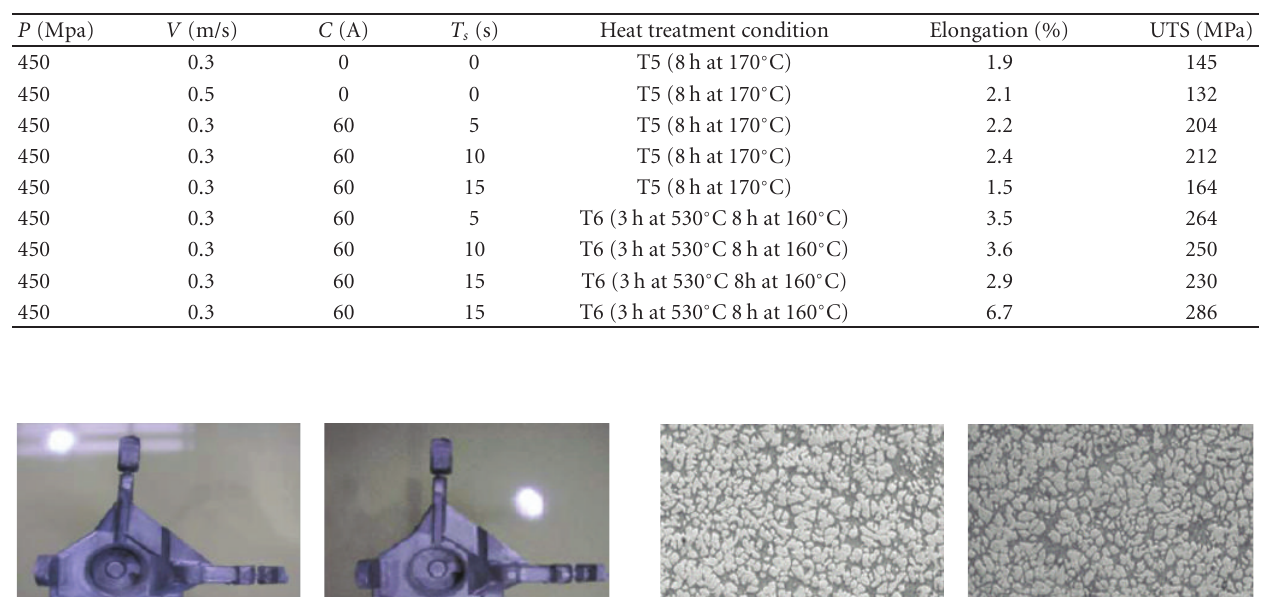
Table 2: The mechanical properties of knuckle part with and without stirring according to each condition.